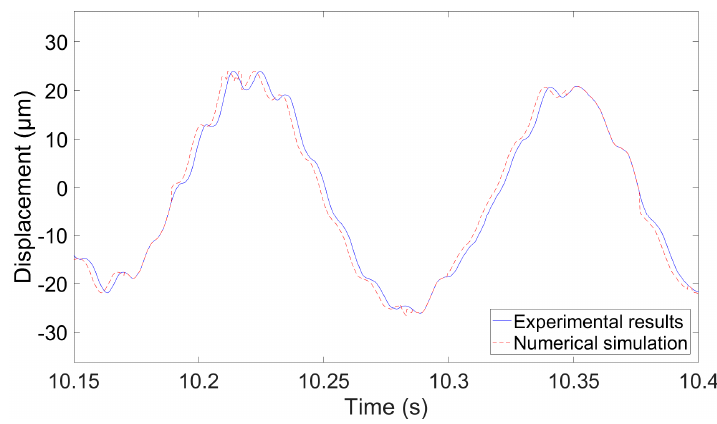
Figure 3. Comparison of time histories of the displacement at point C of the tower model.